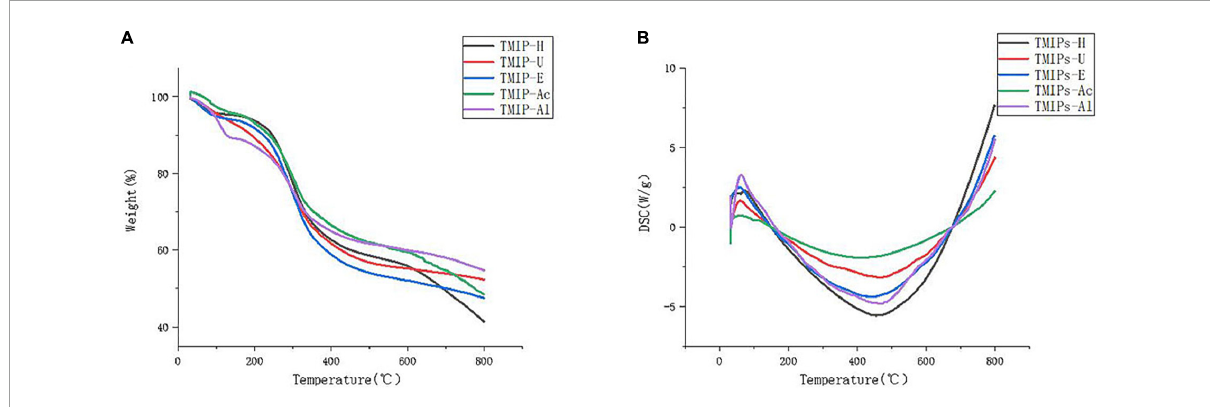
FIGURE3 Thermogravimetric analysis of TMIPs. (A) TG curve and (B) DSC curve.